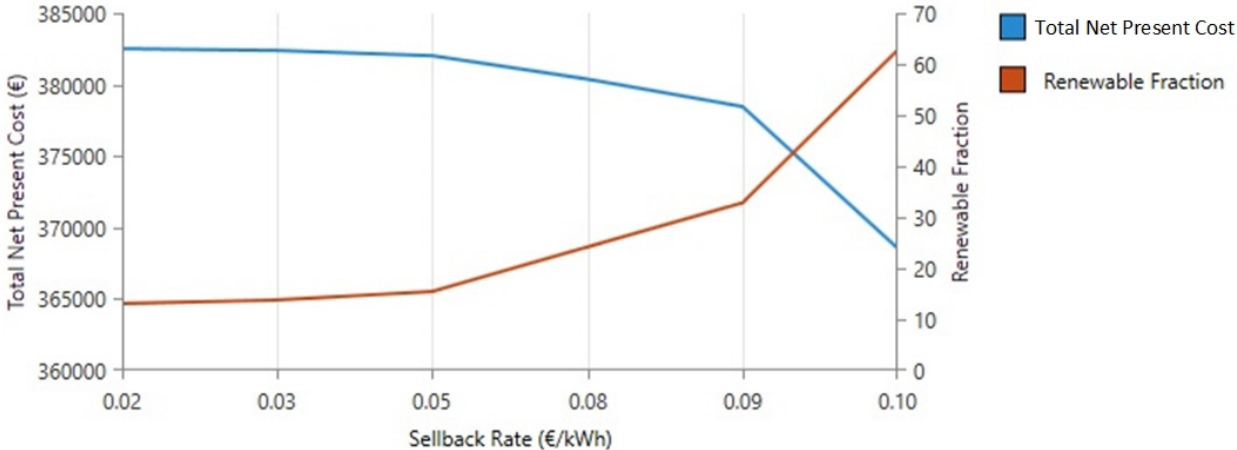
Figure 12. Sensitivity analysis in relation to price of energy delivery to grid.